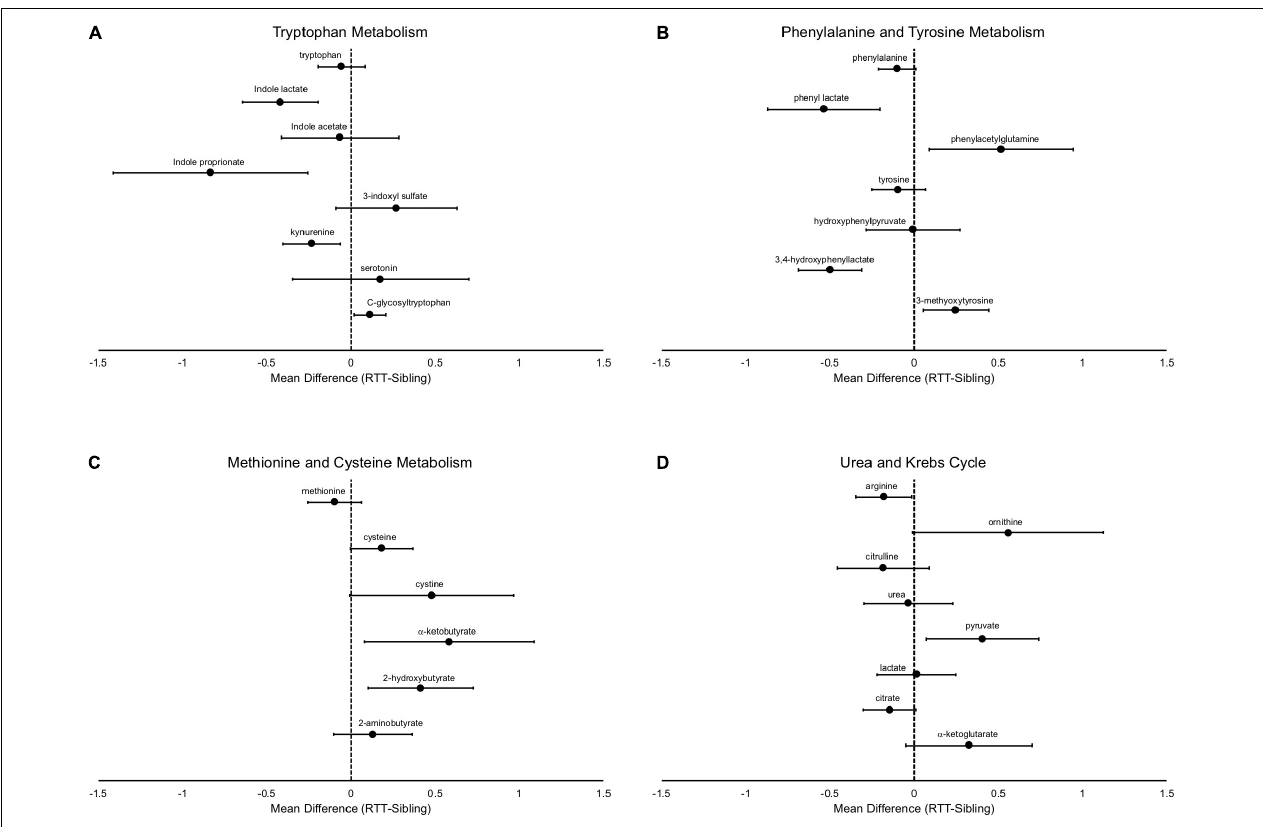
FIGURE 4 | Specific metabolic differences between RTT and unaffected siblings. (A) shows alterations in tryptophan metabolism, (B) shows alterations in phenylalanine and tyrosine metabolism, (C) shows alterations in methionine and cysteine metabolism, and (D) in components of the urea and Krebs cycle. In all panels, the differences of the mean metabolite values between RTT and unaffected siblings is plotted with error bars representing the 95% confidence intervals.